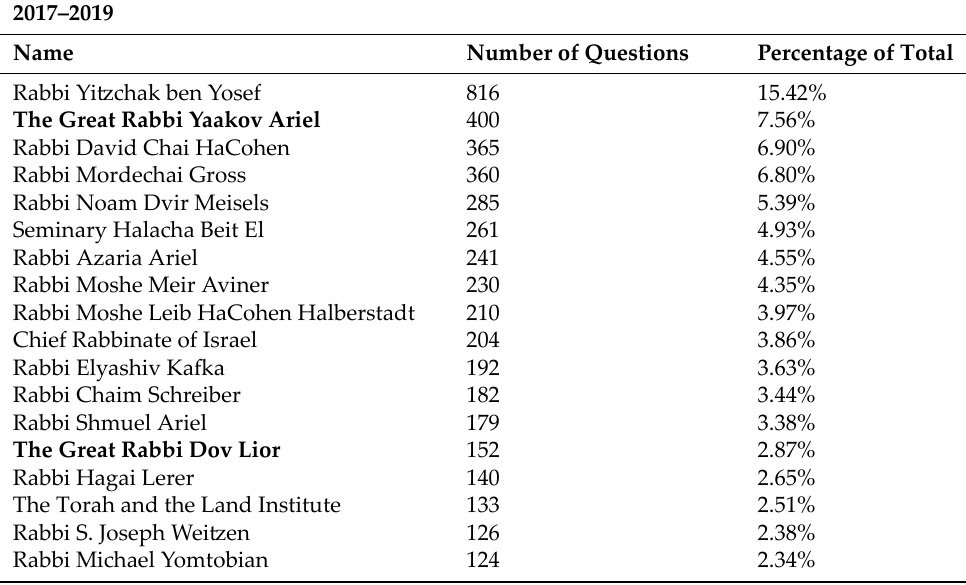
Table A2. Rabbis Who Answered Questions in the Later Years of the Website. The Website Gives the Title “the Great” to Rabbis Who Are Institutionally Recognized and Well Known. The three rabbis who dominated the website’s answers in the earlier years of its activity are in